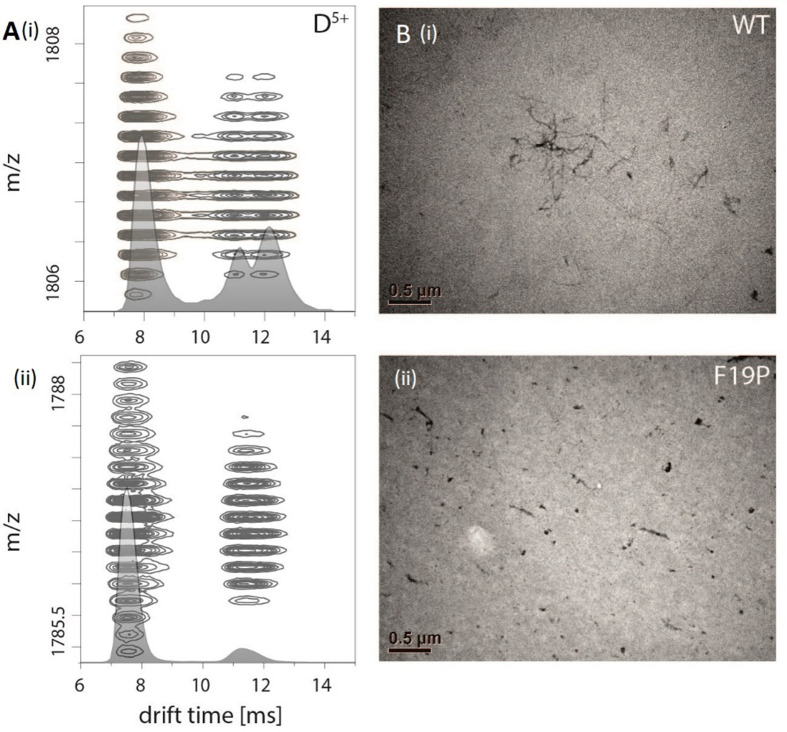
Comparision of Aβ42 wt and mutant F19P.(A) Comparison of the IM spectrum of the 5-times charged dimeric wildtype Aβ42 (i) with that of the Aβ42 mutant F19P (ii) shows loss of the DB structure for the later one. (B) TEM images of both species show that this goes along with the loss of the characteristic fibrillary structures, which can only be seen for Aβ42 wt.